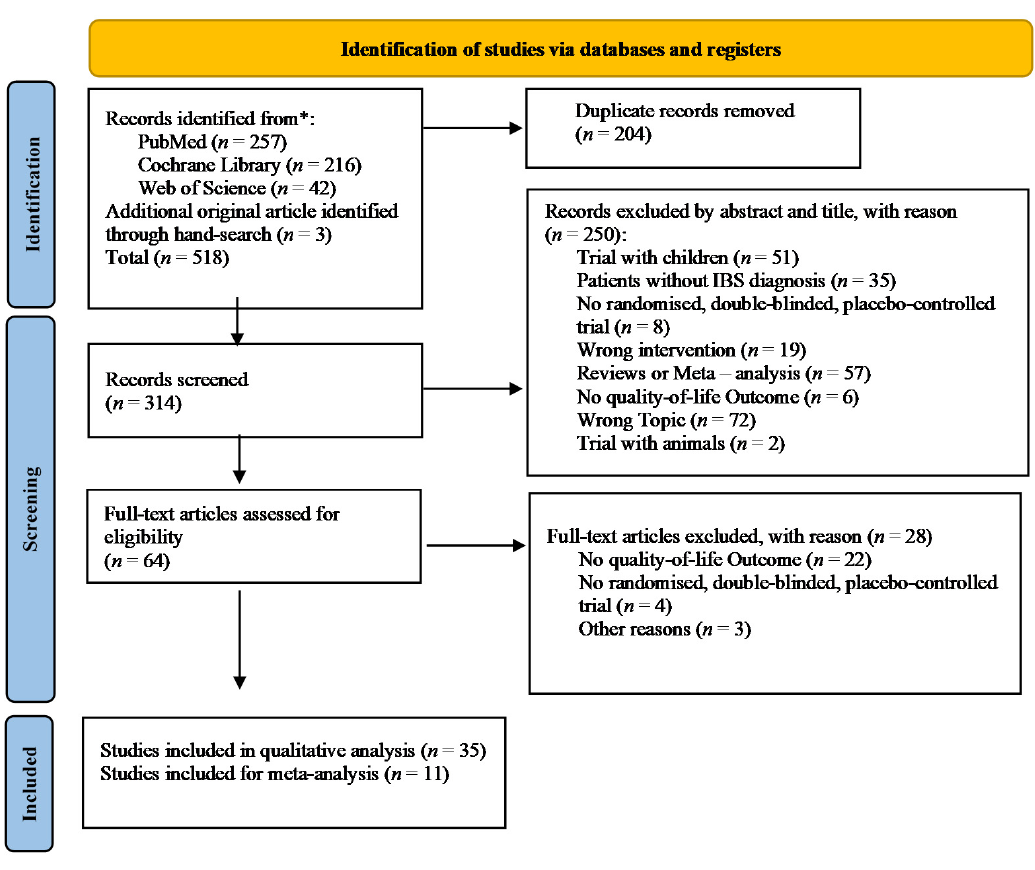
Figure 1. PRISMA flow chart for study inclusion.